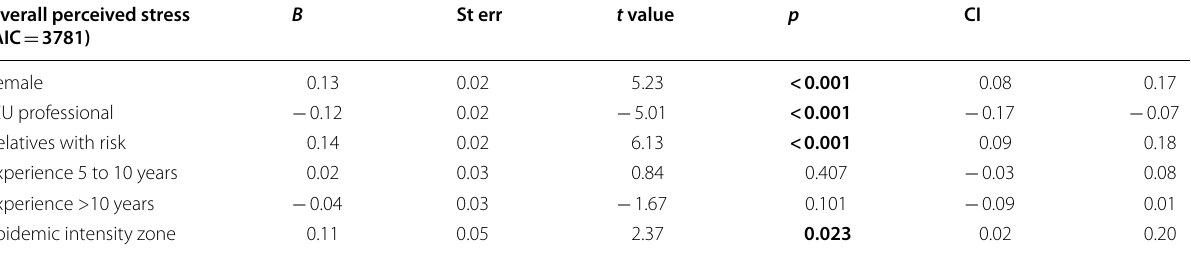
St err standard error, CI confidence interval